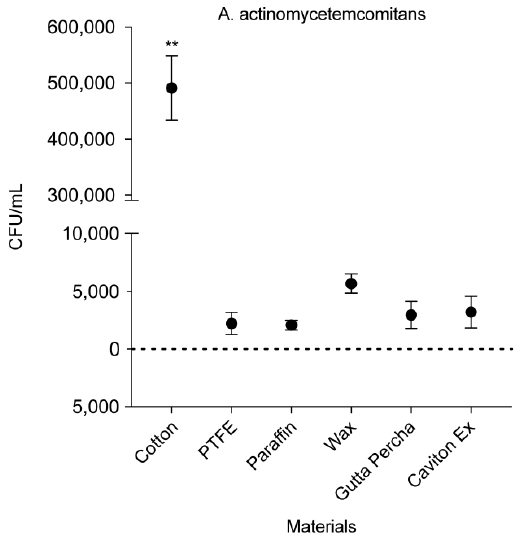
Figure 9. Colony forming units per mL of A. actinomycetemcomitans adhesion against different materials. Data are expressed as mean ± standard deviation ( n = 8; ** p < 0.01).